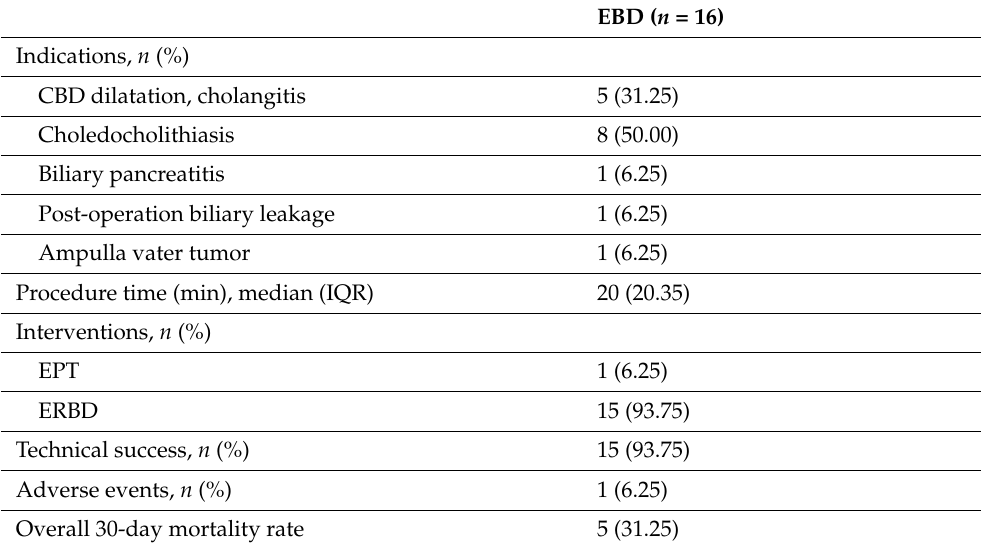
Table 3. ERCP indications, procedures and outcome in 16 patients.